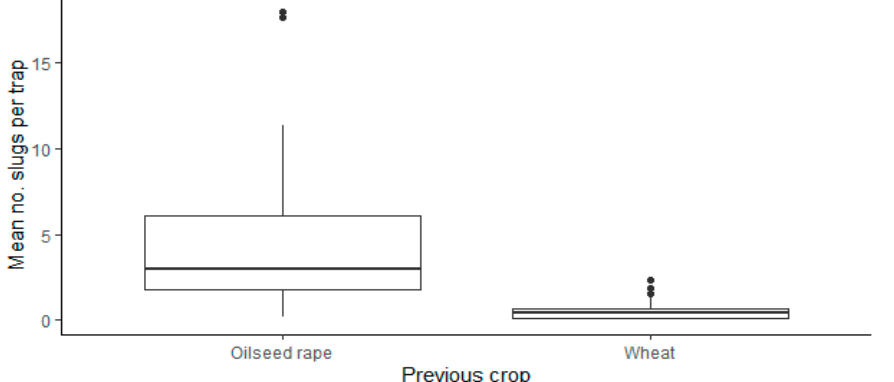
Figure 2. Variation in the total number of slugs recorded in fields where the previous crop was either oilseed rape (11 Fields) or cereals (9 Fields). Slug activity reported as the mean No. slugs per trap in a 10 × 10 grid of refuge traps, set within a rectangular 1ha plot in each field/crop; for details of crops sampled see Table 1. Horizontal line = median x ̅ slugs per trap; bottom and top of box indicate the 25th and 75th percentiles; whiskers = 1.5 x the interquartile range above or below the 25th or 75th percentiles; points are outliers.